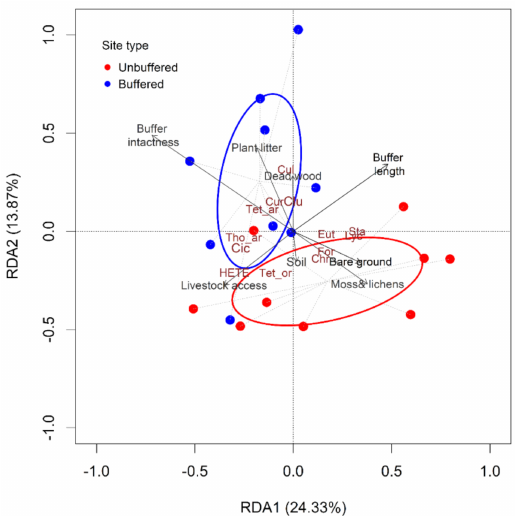
Figure 5. Redundancy analysis (pRDA) of riparian invertebrate communities at nine paired sites in the Arges basin, Romania, showing the influence of riparian attributes after conditioning out , confounding Spatial location and Catchment level variables (i.e., land use). Riparian attributes used in the pRDA are shown in black (auto-correlated variables were not included in the analysis; Pearson’s correlation, p < 0.05). Buffer intactness, Buffer length, %Bare-ground, %Small trees and shrubs, %Moss and lichens, %Plant litter, %Herbs, Dead wood volume, and Soil drainage were included. The species with the highest scores along the first two pRDA axes are shown in dark brown: Araneae: Thomisidae = Tho_ar, Tetragnathidae = Tet_ar, Clubionidae = Clu, Culicidae = Cul, Coleoptera: Curculionidae = Cur, Hemiptera: Cicadidae = Cic are associated with buffered sites (blue ellipse and blue dots), whereas other Hemiptera = HETE, Orthoptera: Tettigoniidae = Tet_or, Hymenoptera: Formicidae = For, Coleoptera: Staphylinidae = Sta, Chrysomelidae = Chr, Araneae: Lycosidae = Lyc, Eutichuridae = Eut, are associated with unbuffered sites (red ellipse and red